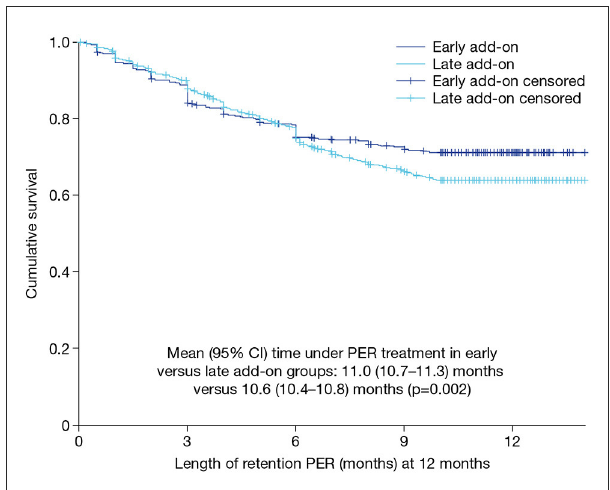
FIGURE1 Kaplan–Meier curve for retention on PER treatment over 12 months in the early and late add-on subgroups (retention population). CI, confidence interval; PER,